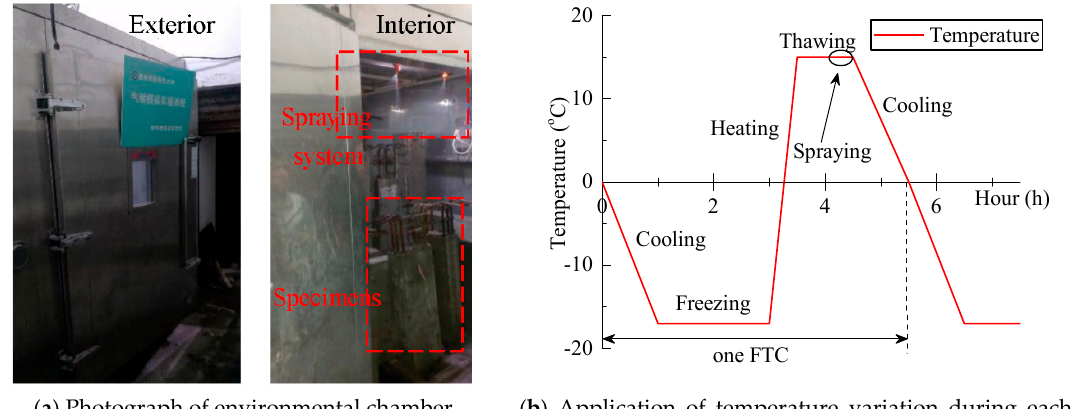
Figure 2. Details of environmental chamber.